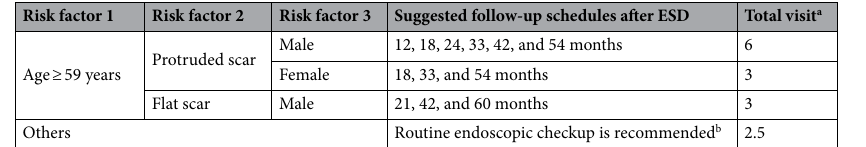
Table 5. Suggested surveillance interval according to risk factor categorization in patients with gastric adenoma after endoscopic submucosal dissection with curative resection. The risk factors are determined after 3 months follow-up endoscopy in patients with endoscopic submucosal dissection. Suggested follow-up schedule is established when the patient has all three risk factors (risk factor 1, 2, and 3). ESD, endoscopic submucosal dissection. a This number excludes 3 months follow-up endoscopy (1st follow up). b Biennial endoscopy is recommended if a protruded scar is noted at the 3-month follow-up endoscopy after